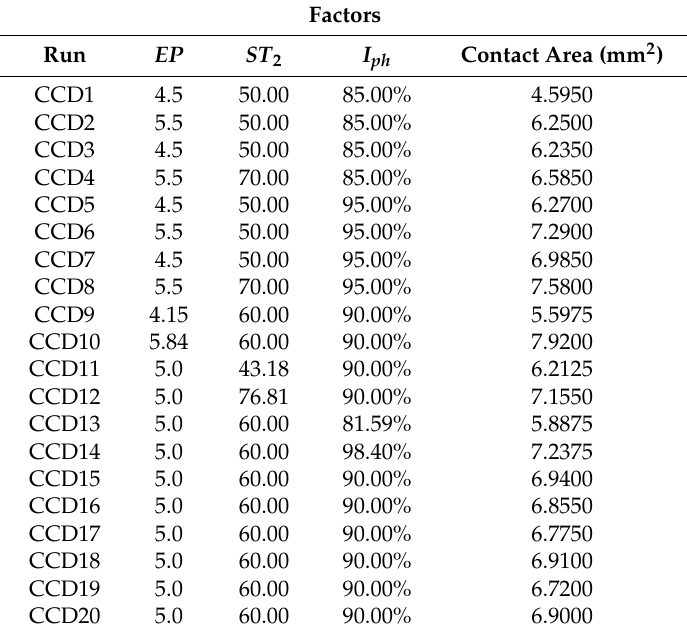
Table 7. Experimental